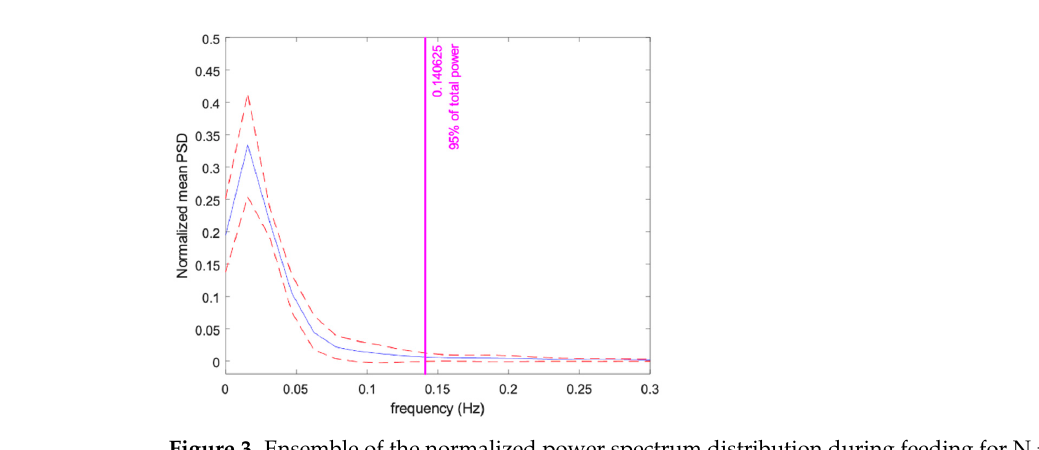
( b ) Figure 5. ( a ) Boxplot for SCL at pre-feeding and feeding stages ( p -value = 0.1049). ( b ) Boxplot for NS.SCR at pre-feeding and feeding stages ( p -value = 0.0281). * Represents statistically significantly differences ( p -value < 0.05) between pre-feeding and feeding. Figure 6 shows the ensemble average of the phasic component of all horses aligned using the startle time (the exact time at which the umbrella was opened) in such a way that the values where all set to zero at this particular reference time. A clear elevation in the phasic component of EDA can be observed across horses. The mean values of tonic and phasic components were found to be non-normally distributed. Hence, a two-sided Wilcoxon rank sum test was applied to evaluate the p -value of each pair of intervals at a 0.05 level of significance. Subsequently, Bonferroni correction was performed. The results indicate that the mean of the phasic component significantly increased in the segment